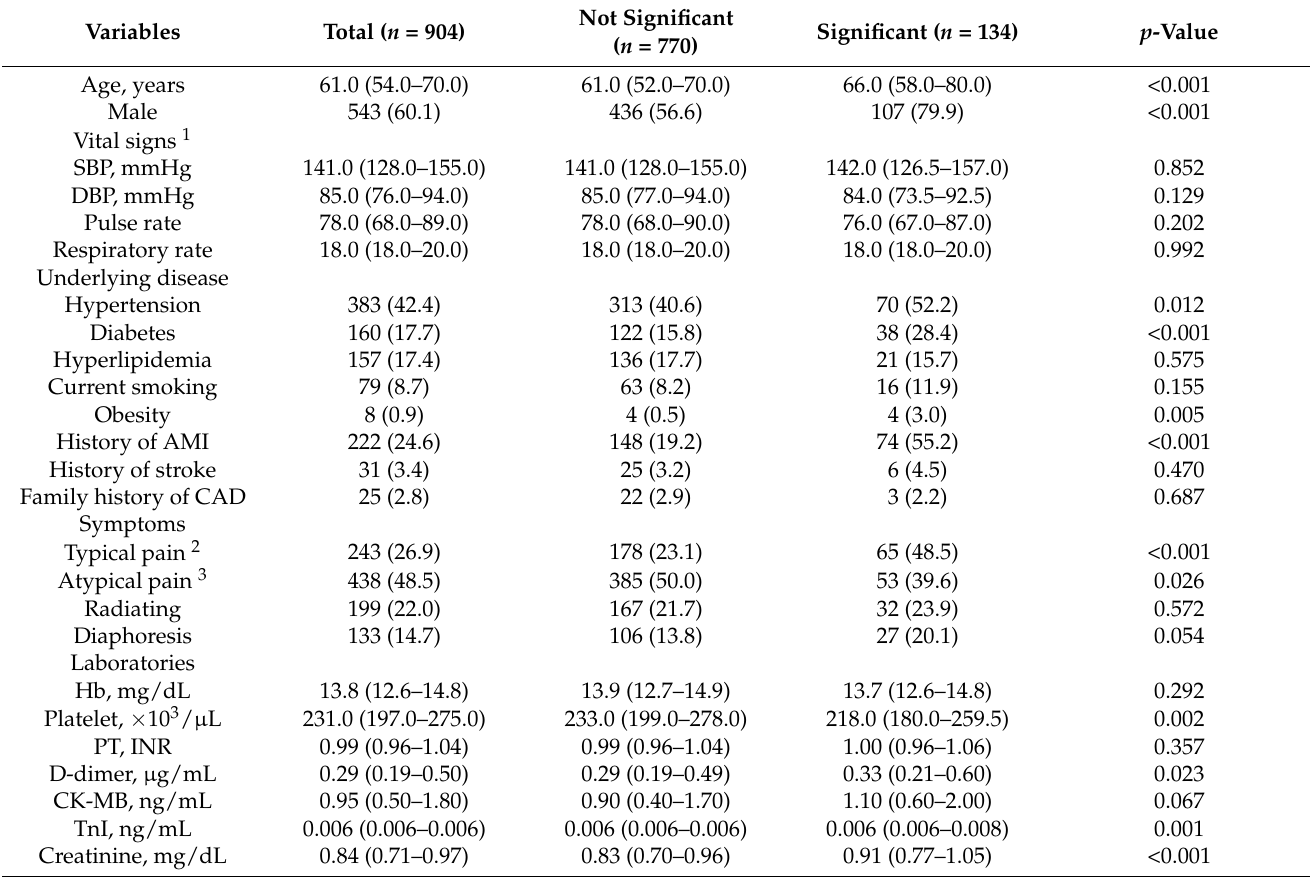
Table 1. Baseline characteristics of the study